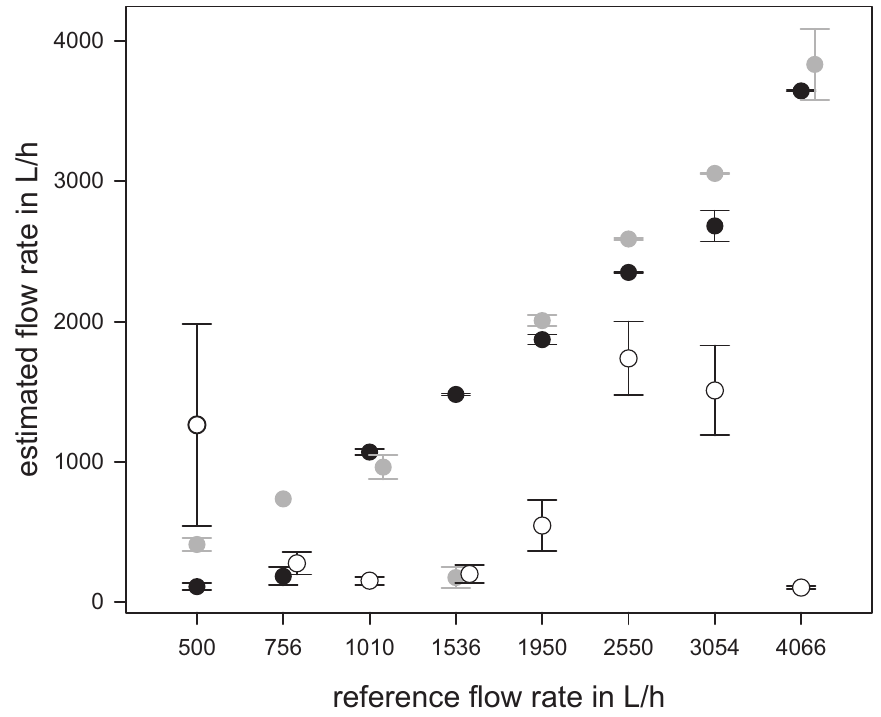
Figure 9. Estimated flow rates for reference flow rates ranging from 500 to 4066 L/h. The plot shows mean values and standard errors. Flow rates were estimated from cross-correlations of sensors 1 and 2 (black circles), sensors 2 and 3 (gray circles) and sensors 1 and 3 (open circles) according to Equation (1). Note that estimated flow rates exceeding the range of 0 to 10,000 L/h were excluded from the figure (about 12% for S1 and S2, 8% for S2 and S3, 35% for S1 and S3). Please note that reference values along the x -axis are not equally